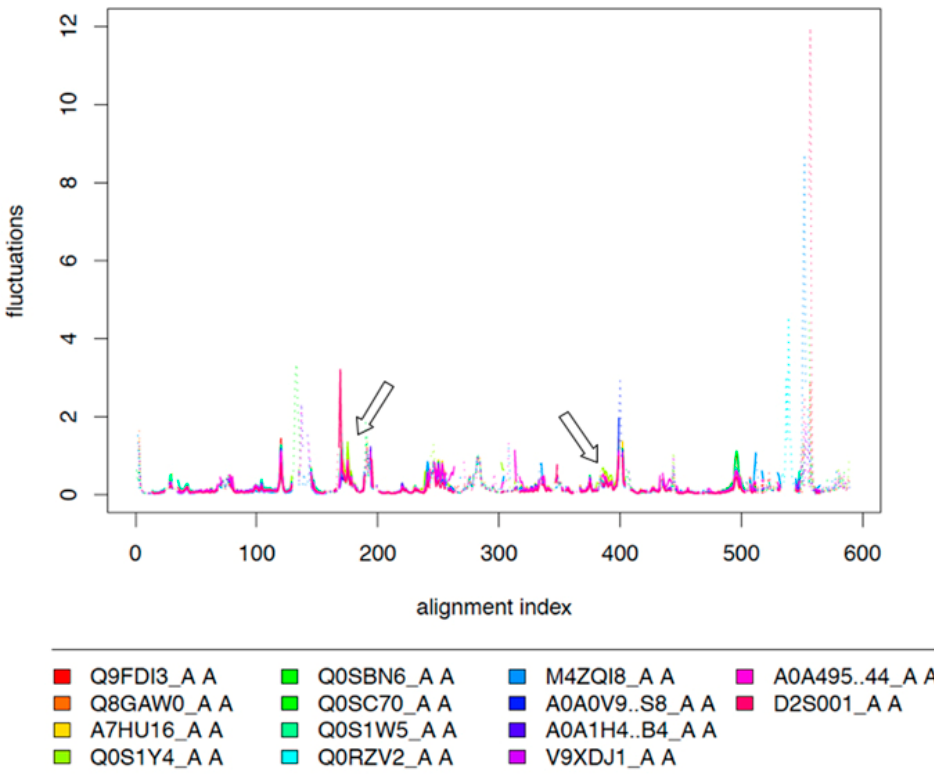
Figure 3. Comparative normalised fluctuation plot of the Class 1 BVMOs . The fluctuations describe the flexibility of the C α atoms of the enzymes. Residue numbers are given on the x-axis and the amplitude of fluctuations on the y-axis. The parts aligned with gaps in other structures are shown as dotted lines. Only Rj BVMO1 presents a spike around positions 180 and 390 (see arrows).